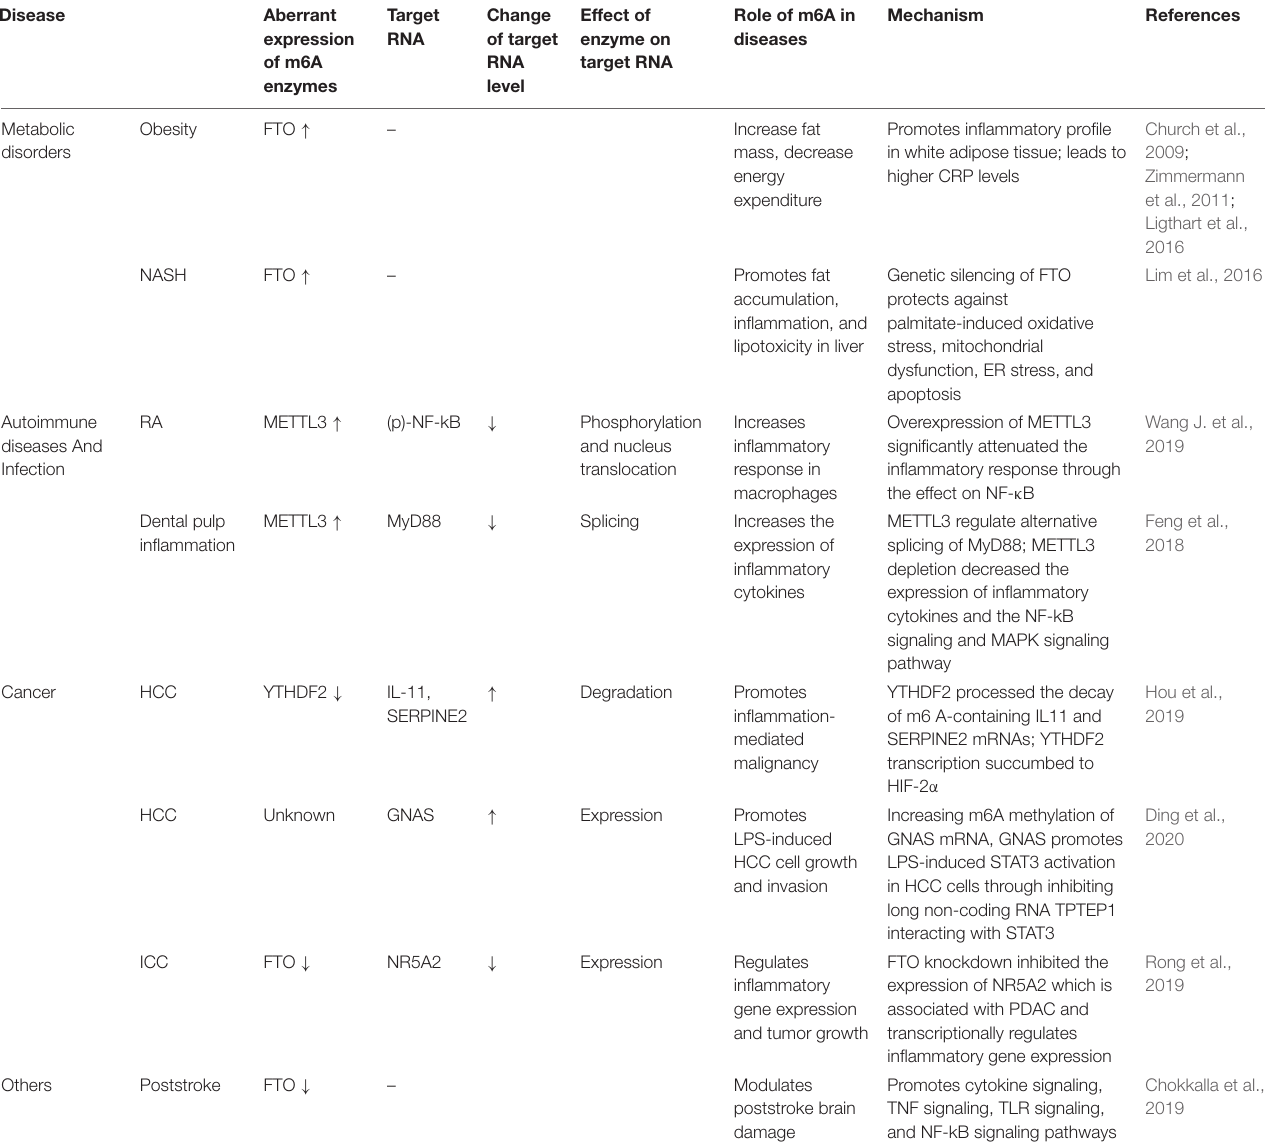
TABLE 1 | Roles of m6A in RNA metabolism and inflammatory